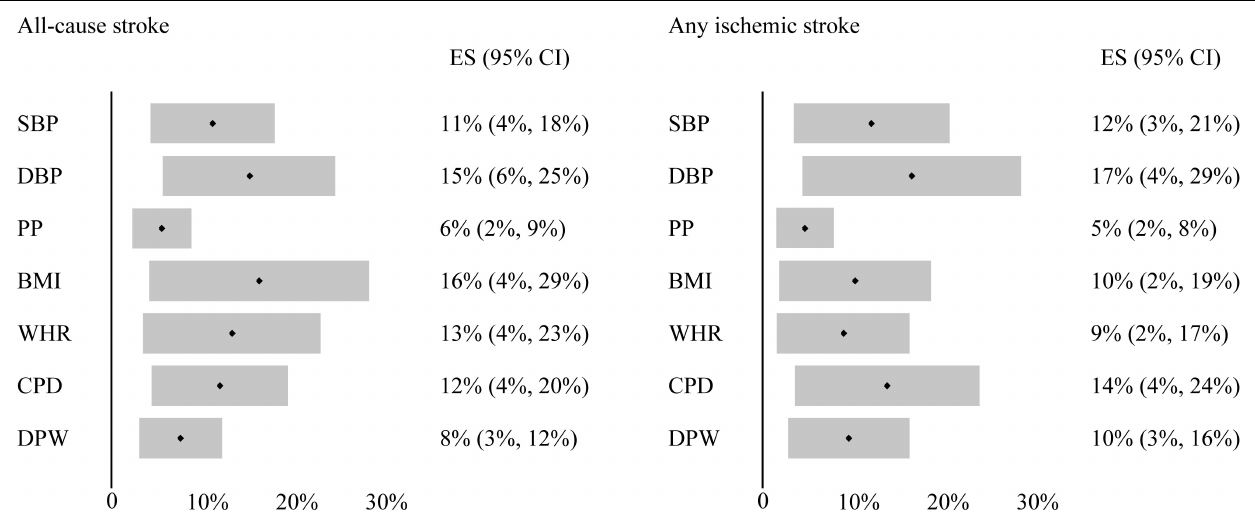
FIGURE 3 | Mediation analysis of the effect of television watching on all-cause stroke and any ischemic stroke. Black dot indicates the average proportion, and gray bar indicates the 95% confidence intervals. ES, estimate for certain factor mediating the effect of television watching on stroke outcomes; CI, confidence interval; CPD, cigarettes per day; DPW, drinks per